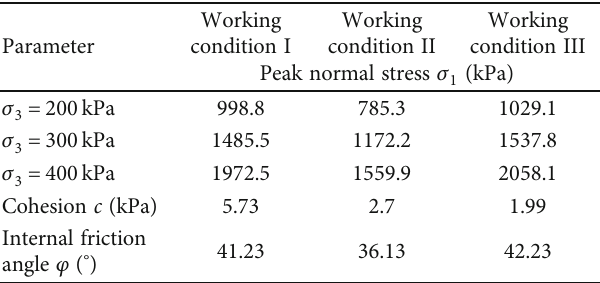
Table 2: Summary of results of three working conditions.